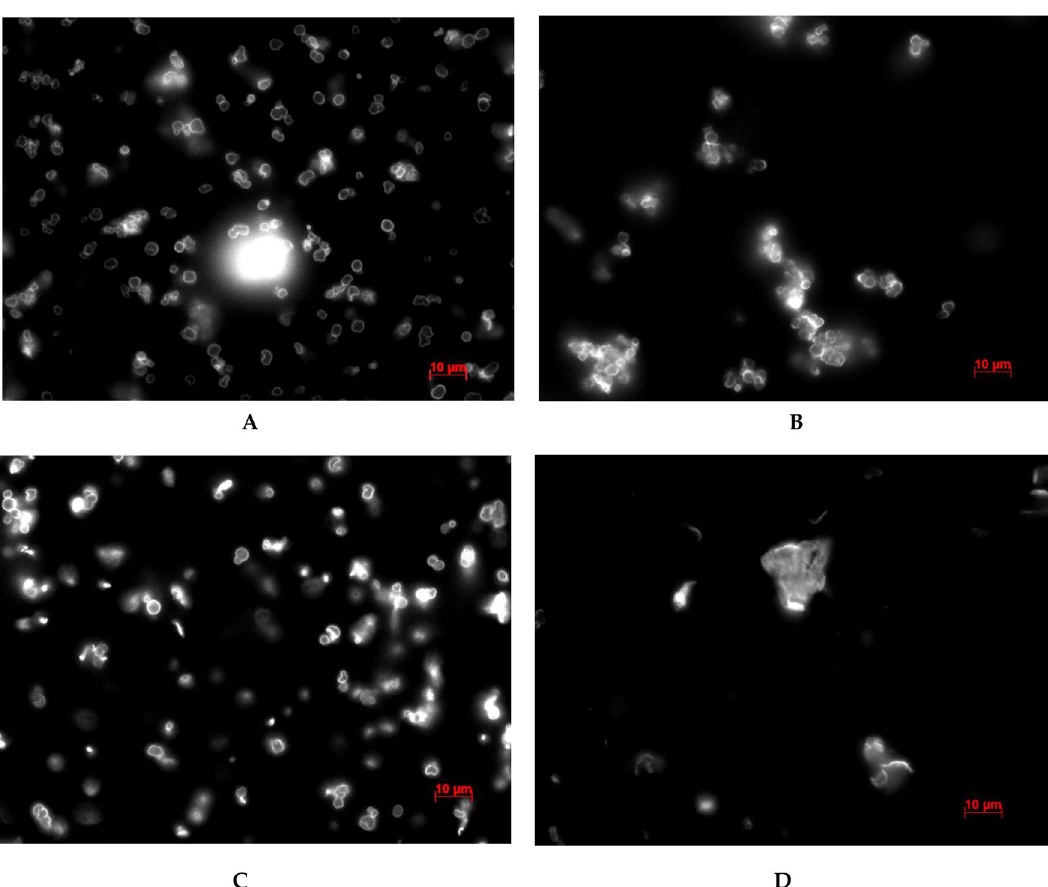
Figure 4. Image of polyelectrolyte microcapsules in water and 3000 μg/ml SDS solution before and after 24 h of incubation. ( A ) PMC in water solution before incubation. ( B ) PMC in 3000 μg/ml SDS solution before incubation. ( C ) PMC in water solution after 24 h incubation. ( D ) PMC in 3000 μg/ml SDS solution after 24 h